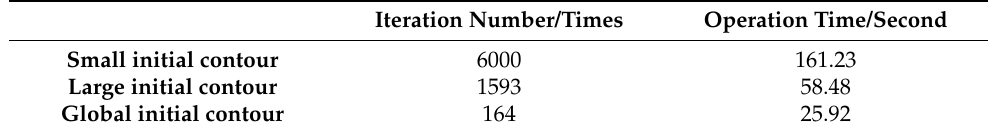
Table 3. Comparison of different initial contour extraction results.